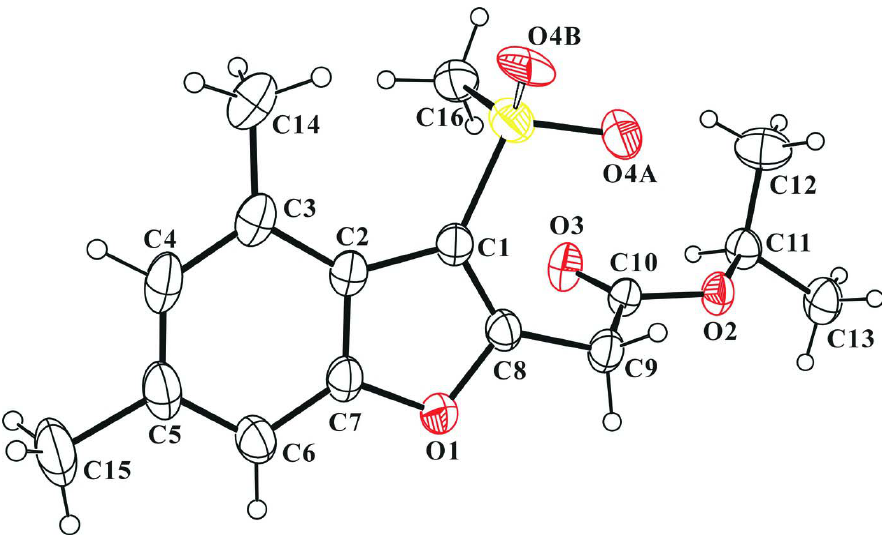
Figure 1 The molecular structure of the title compound, showing displacement ellipsoids drawn at the 30% probability